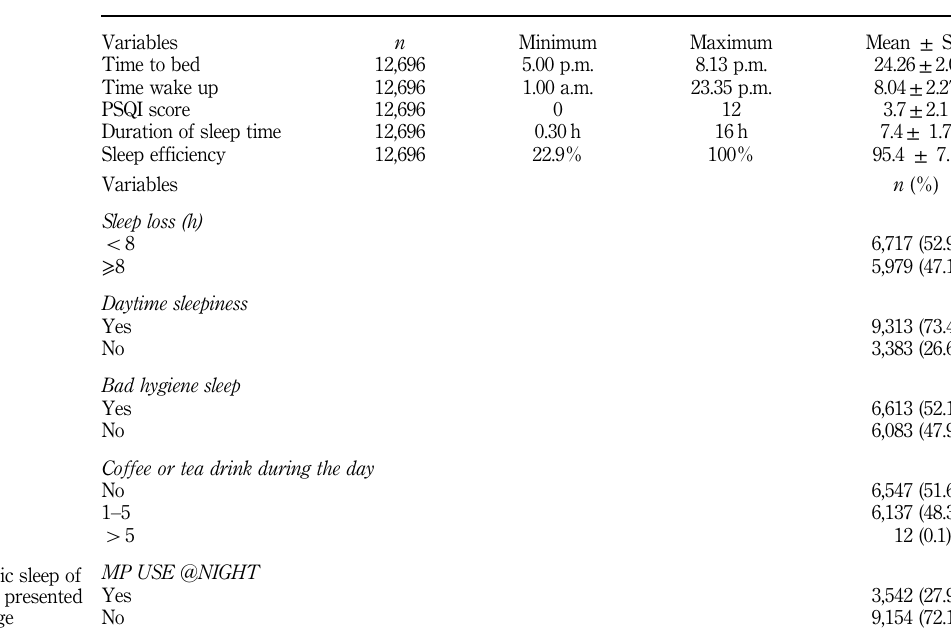
Table I. Characteristic sleep of participants presented as